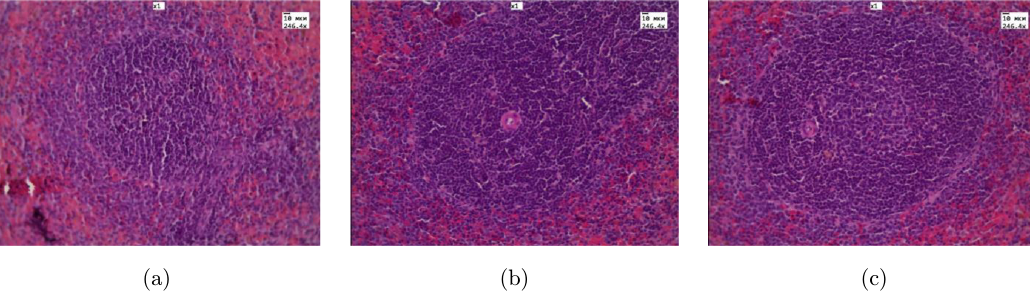
Fig. 4. Histological sections of spleen: (a) Comparison group (rats with PC-1). Lymphoid follicle of the spleen; (b) Group with laser hyperthermia. Increase of periarterial zone of lymphoid follicle of the spleen. (c) Group with PPTT. The germinal center of lymphoid follicle. Staining with hematoxylin and eosin. ( (cid:3) 246 ; 4).